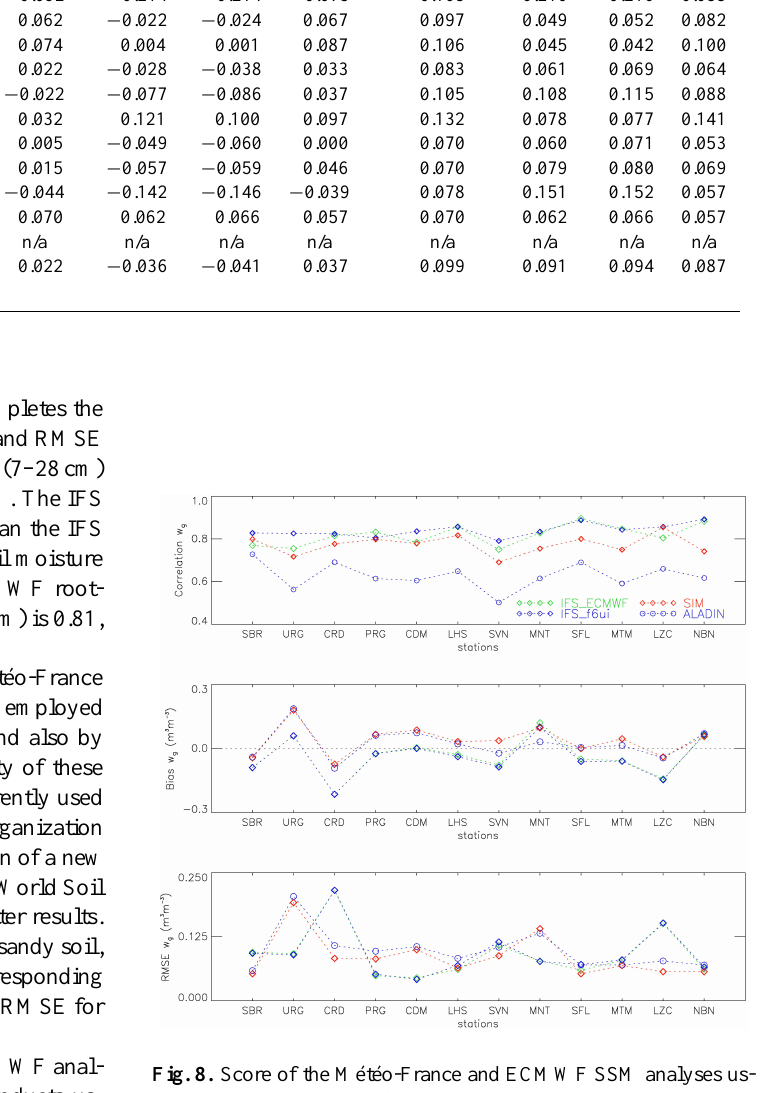
Fig. 8. Score of the M´et´eo-France and ECMWF SSM analyses us- ing the twelve stations of the SMOSMANIA network. From top to bottom: correlation, mean bias and RMSE. In situ SSM ob- servations are used to evaluate SSM analysis from M´et´eo-France (ALADIN in blue dots and SIM in red diamonds) and ECMWF (Optimal Interpolation with T 2m and RH 2m in green diamonds, SEKF with T 2m and RH 2m and ASCAT SSM estimates in blue